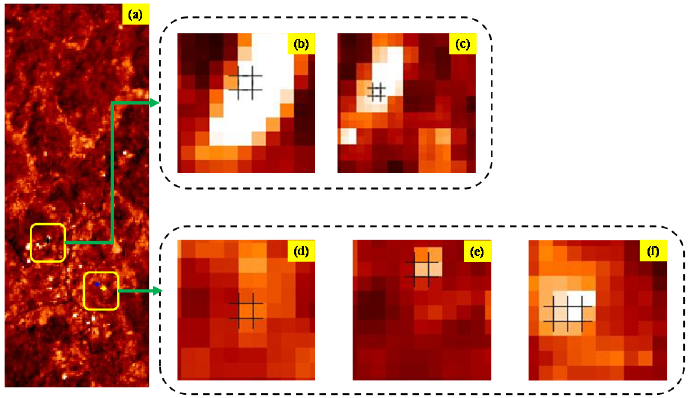
Figure 8. Target detection score image ( a ) from space-borne imagery using in-situ target reference spectrum and the enlarged detection score footprint for ( b ) N3Y, ( c ) N4B, ( d ) N1G, ( e ) N2R, and ( f ) C1W targets.